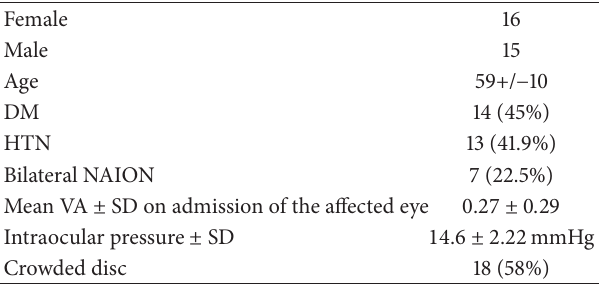
Table 1: Demographics among NAION group ( 𝑛 = 31 ).